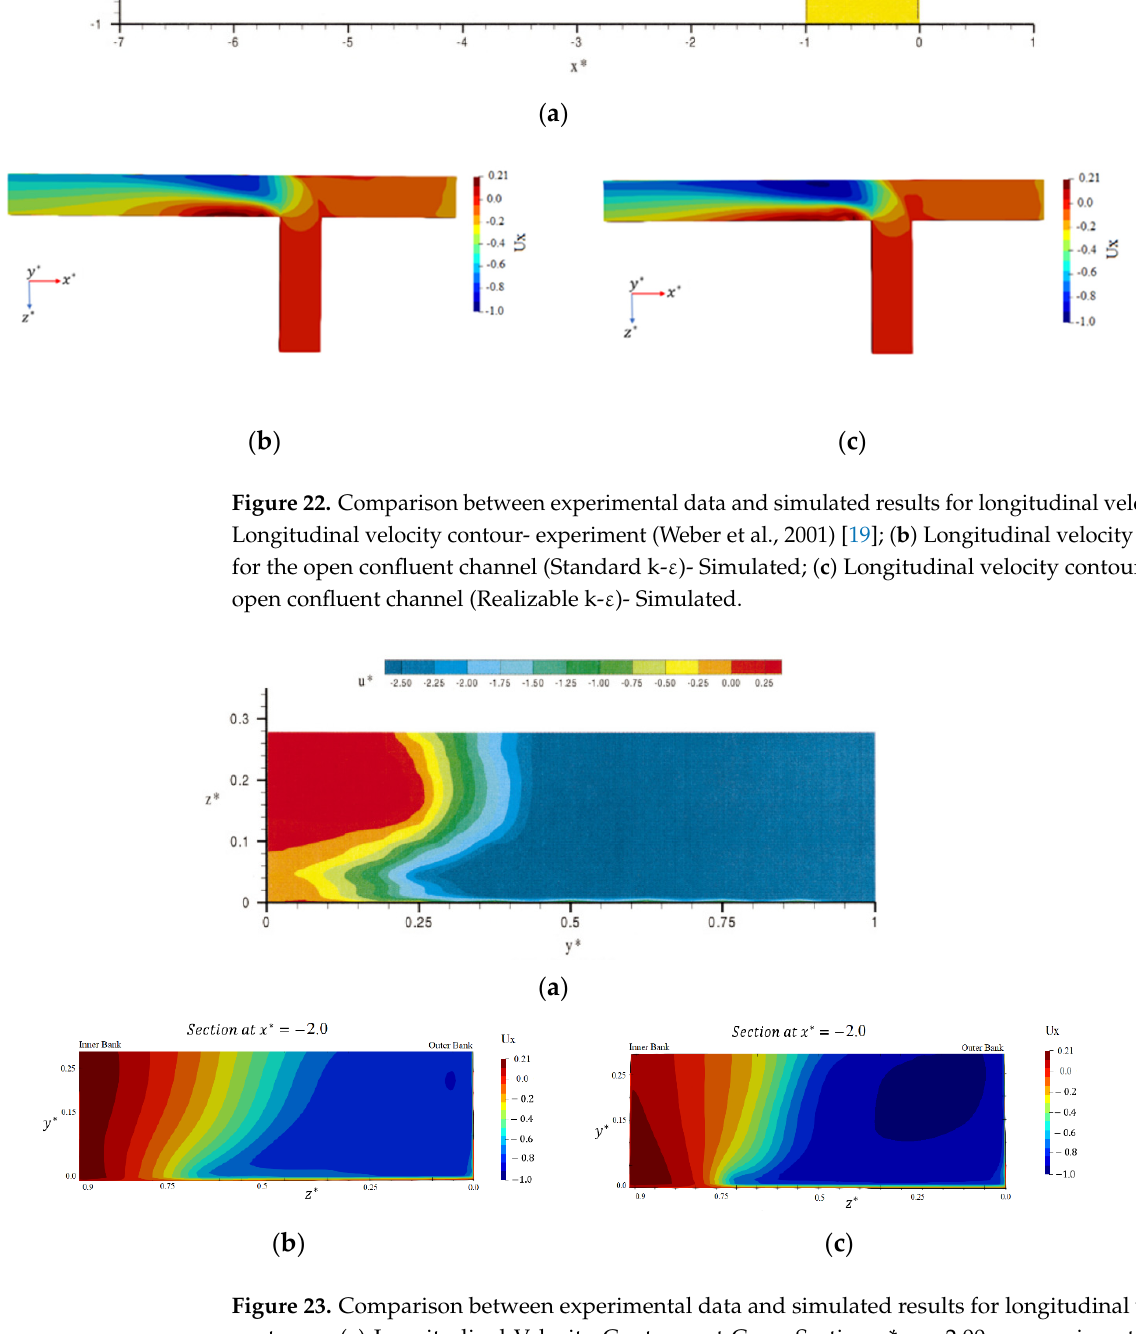
Figure 23. Comparison between experimental data and simulated results for longitudinal velocity contours. ( a ) Longitudinal Velocity Contours at Cross-Section x* = − 2.00 − experiment (Weber et al., 2001) [19]; ( b ) Longitudinal Velocity Contours at Cross-Section x* = − 2.00 − (Standard k- ε )- Simulated; ( c ) Longitudinal Velocity Contours at Cross-Section x* = − 2.00 − (Realizable k- ε )-